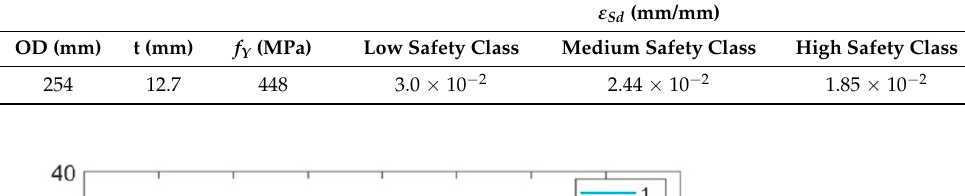
Table 4. Seismic